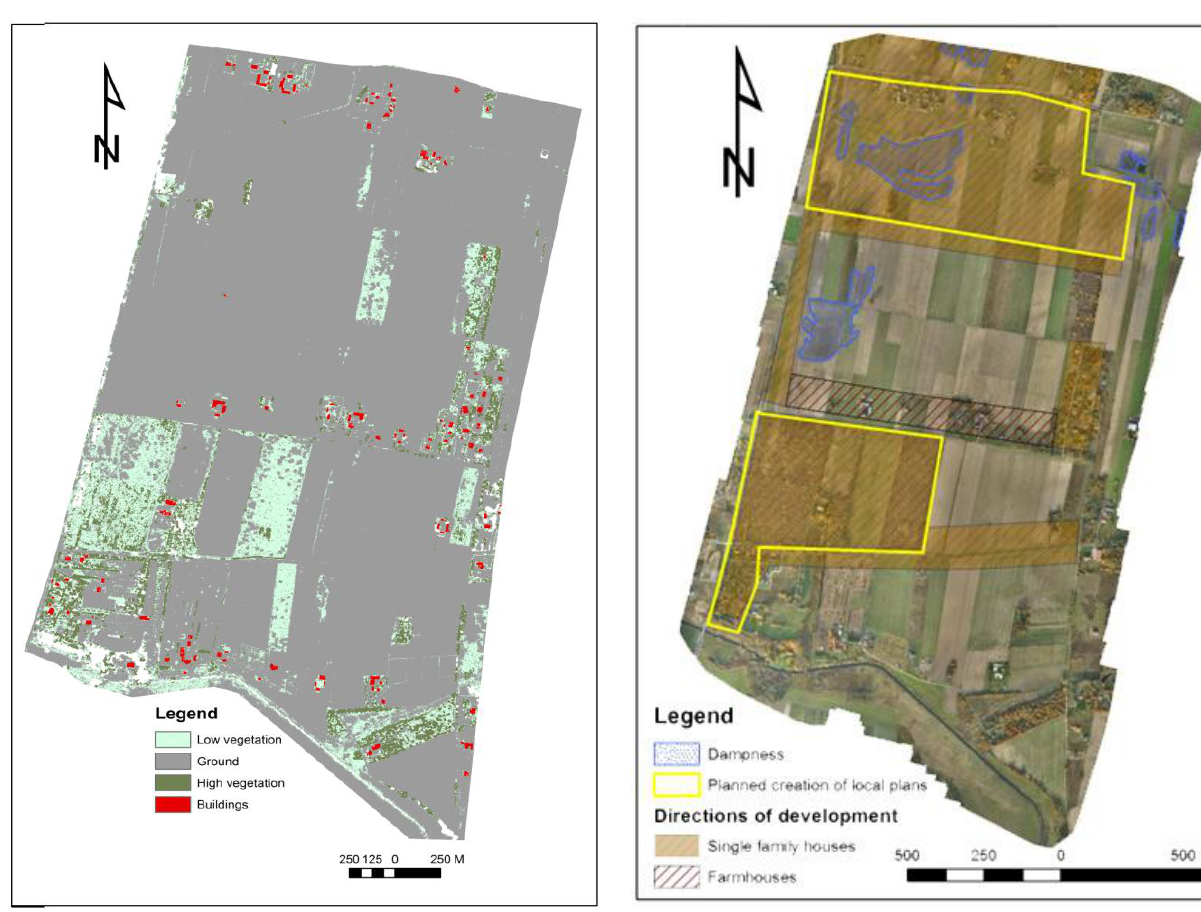
Figure. 1 A land cover map resulting from classification of a point cloud generated from dense image matching.